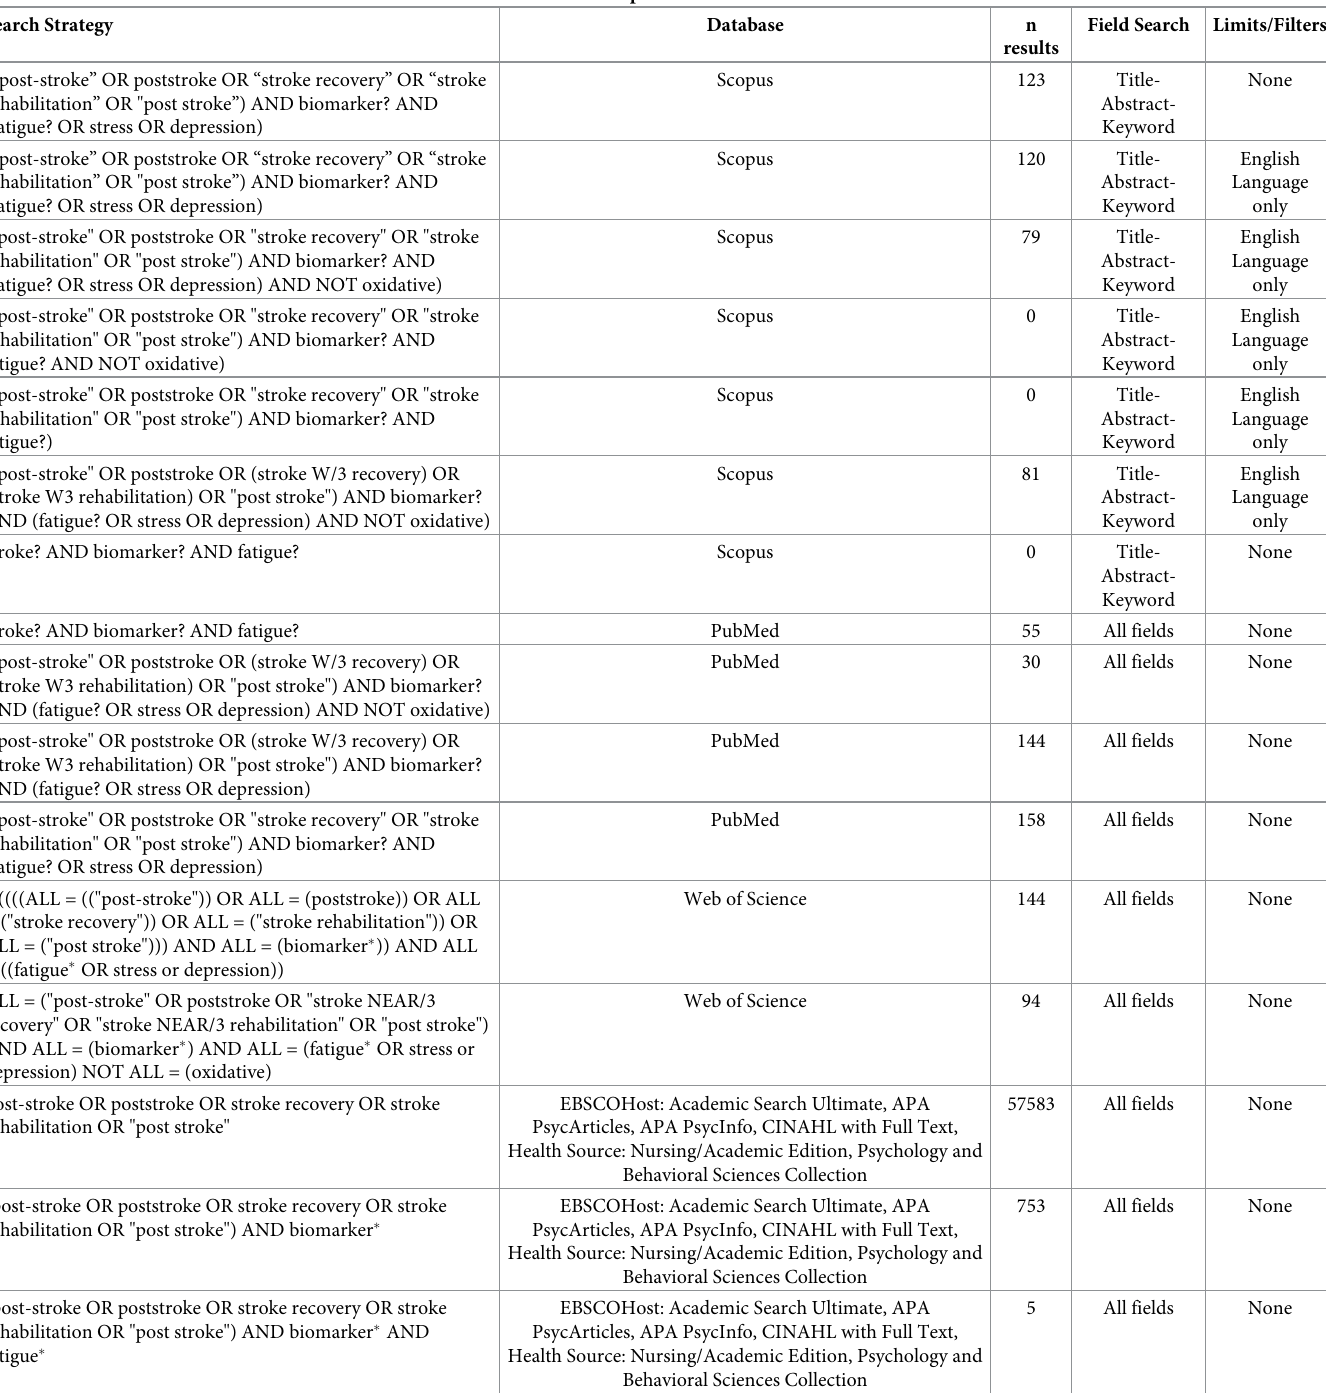
Table 2. Search strategy